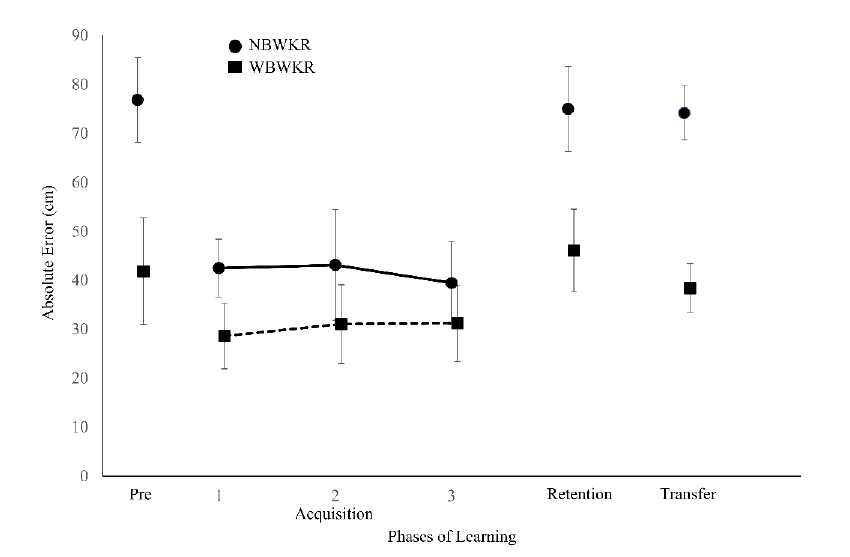
Figure 2. Number of hits throughout the phases of the study (errors bars represent standard error)